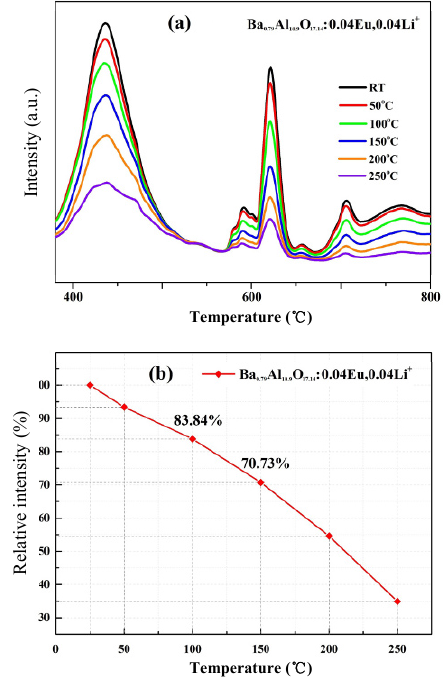
Fig. 12 (a) Temperature-dependent emission spectra of Ba 0.79 Al 10.9 O 17.14 :0.04Eu,0.04Li + and (b) emission intensity function relative to the temperature.